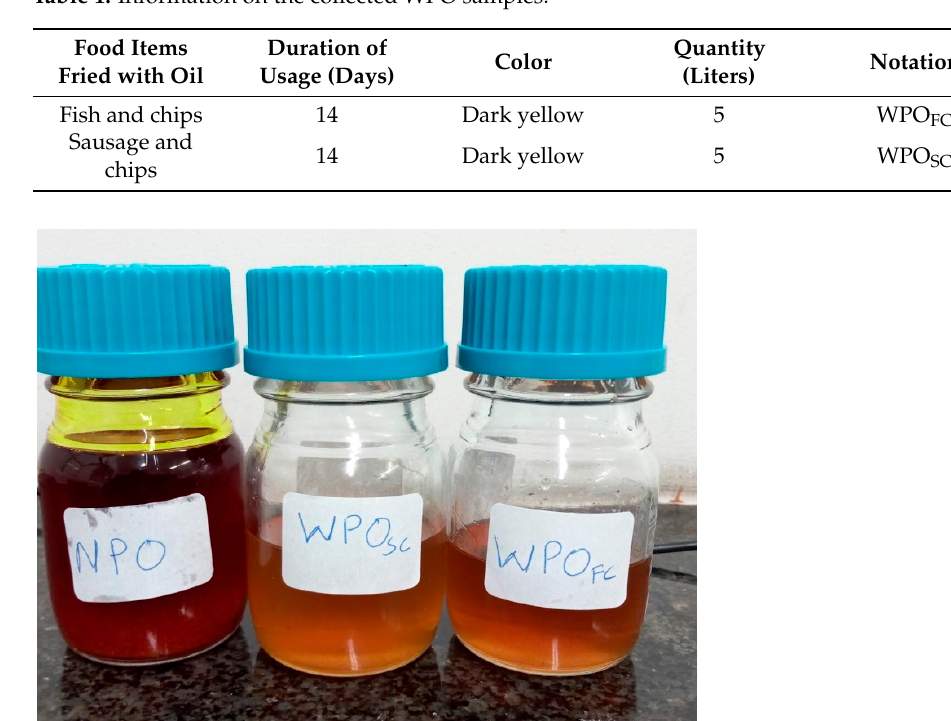
Table 2. Summary of the WPOME production parameters.